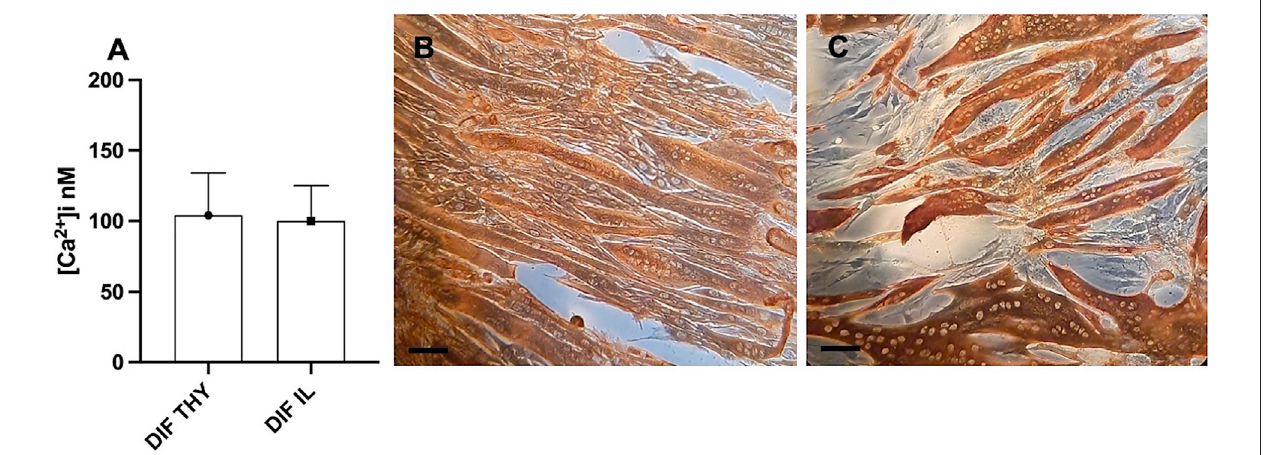
FIGURE 2| Results ofdifferentiated postmortem hMPCs. (A) [Ca 2+ ] i recorded as the basal level in differentiated hMPCs derived from both thyrohyoid (DIF TY) and ileopsoas (DIF IL) muscles. (B,C) Representative images of immunostaining for desmin (B) and myosin heavy chain proteins (C) on myotubes derived from postmortem thyrohyoid hMPCs. The bars represent 100 μ